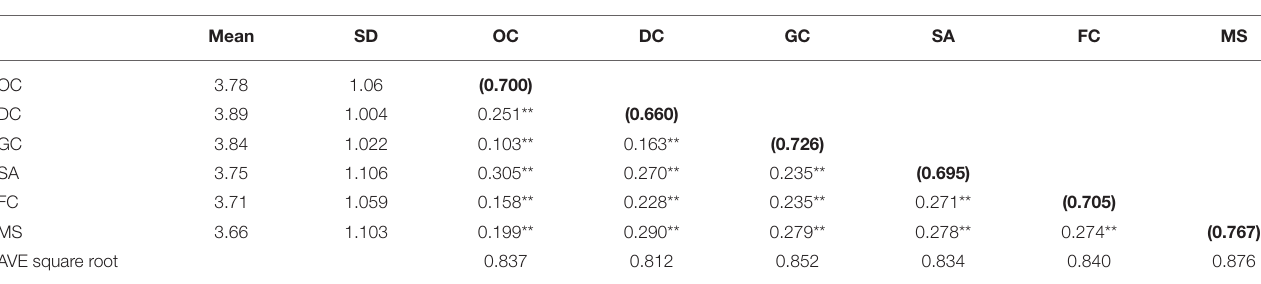
TABLE 3 | Discriminant